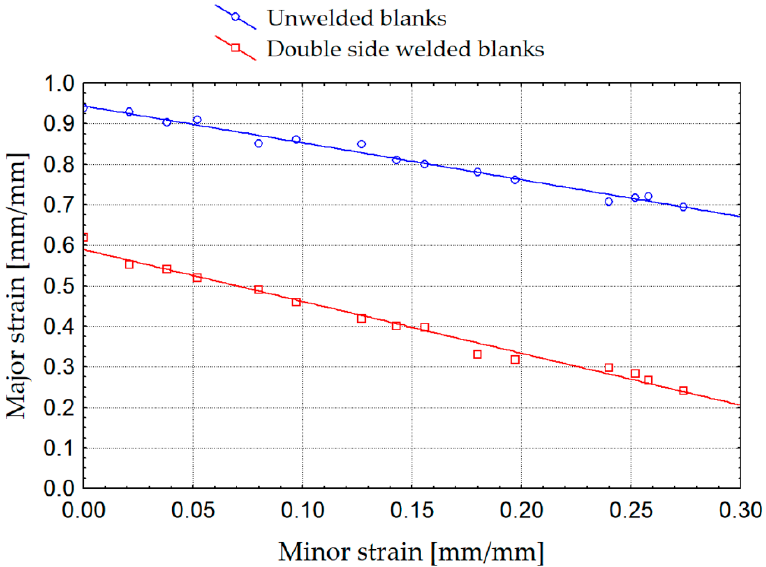
Figure 14. Flow limit curves for unwelded blanks and double side welded blanks processed by SPIF.